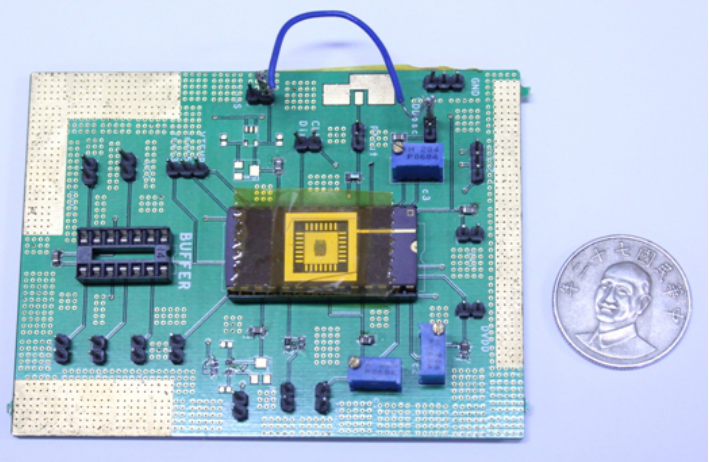
Figure 13. Photograph of the test PCB.